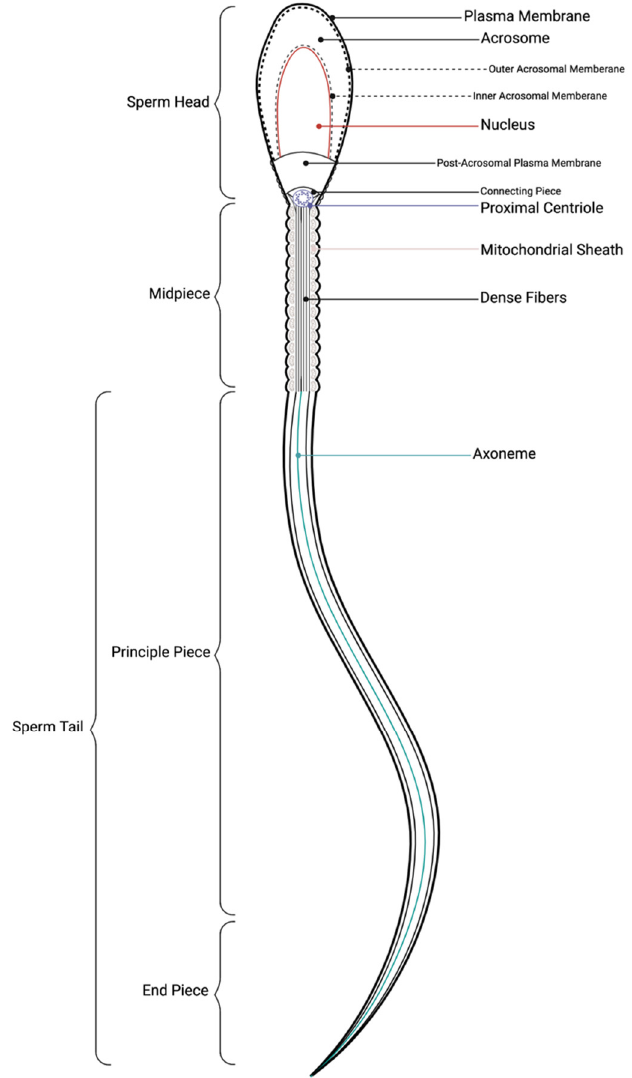
Figure 2. Anatomy of spermatozoa . A spermatozoon consists of three major components: head, midpiece, and tail. The sperm head is overlaid by a plasma membrane, and an acrosomal compartment containing enzymes to aid in fertilization. The nucleus, sur- rounded by the nuclear envelope, contains the compacted male genome. The head is connected to the midpiece by the connecting piece. The midpiece consists of the proximal centriole, the mitochondrial sheath, and an inner dense fiber structure. The tail points distally, is also covered by a plasma membrane, surrounding the structural